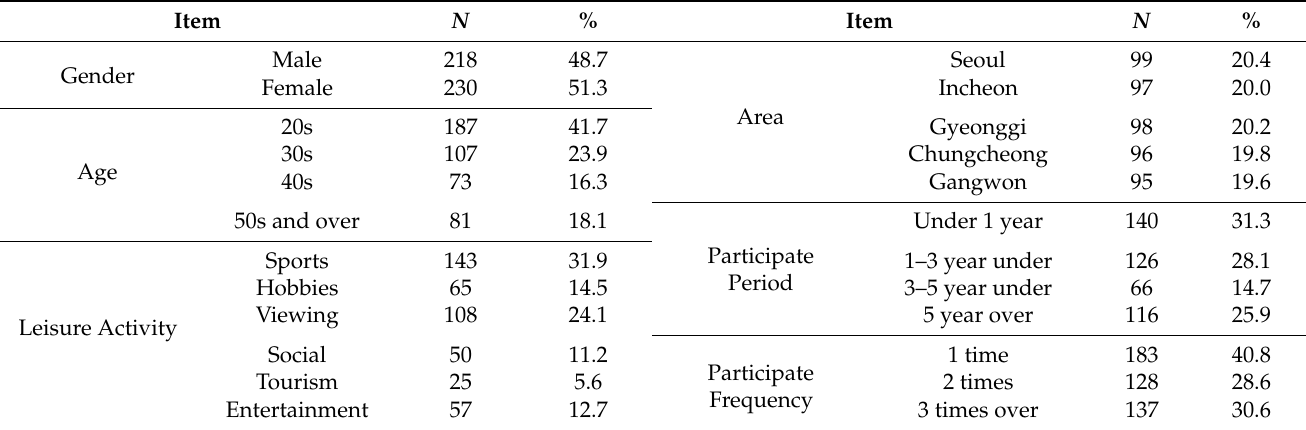
Table 1. Description of participants ( N =